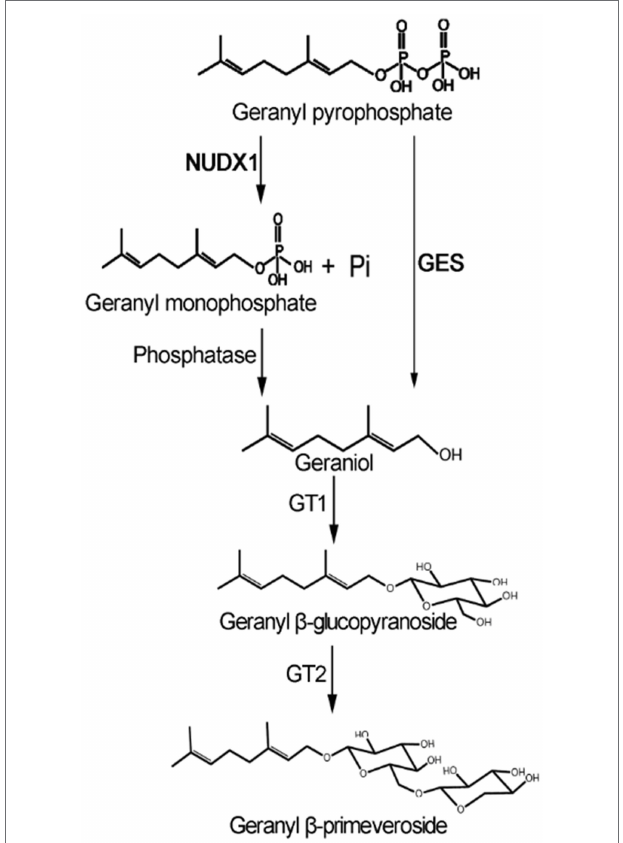
FIGURE 1 | Possible pathways for geraniol and its glycoside production in tea plants. GES, geraniol synthase; NUDX1, Nudix hydrolase1; GT1, UDP- glycosyltransferases; GT2,